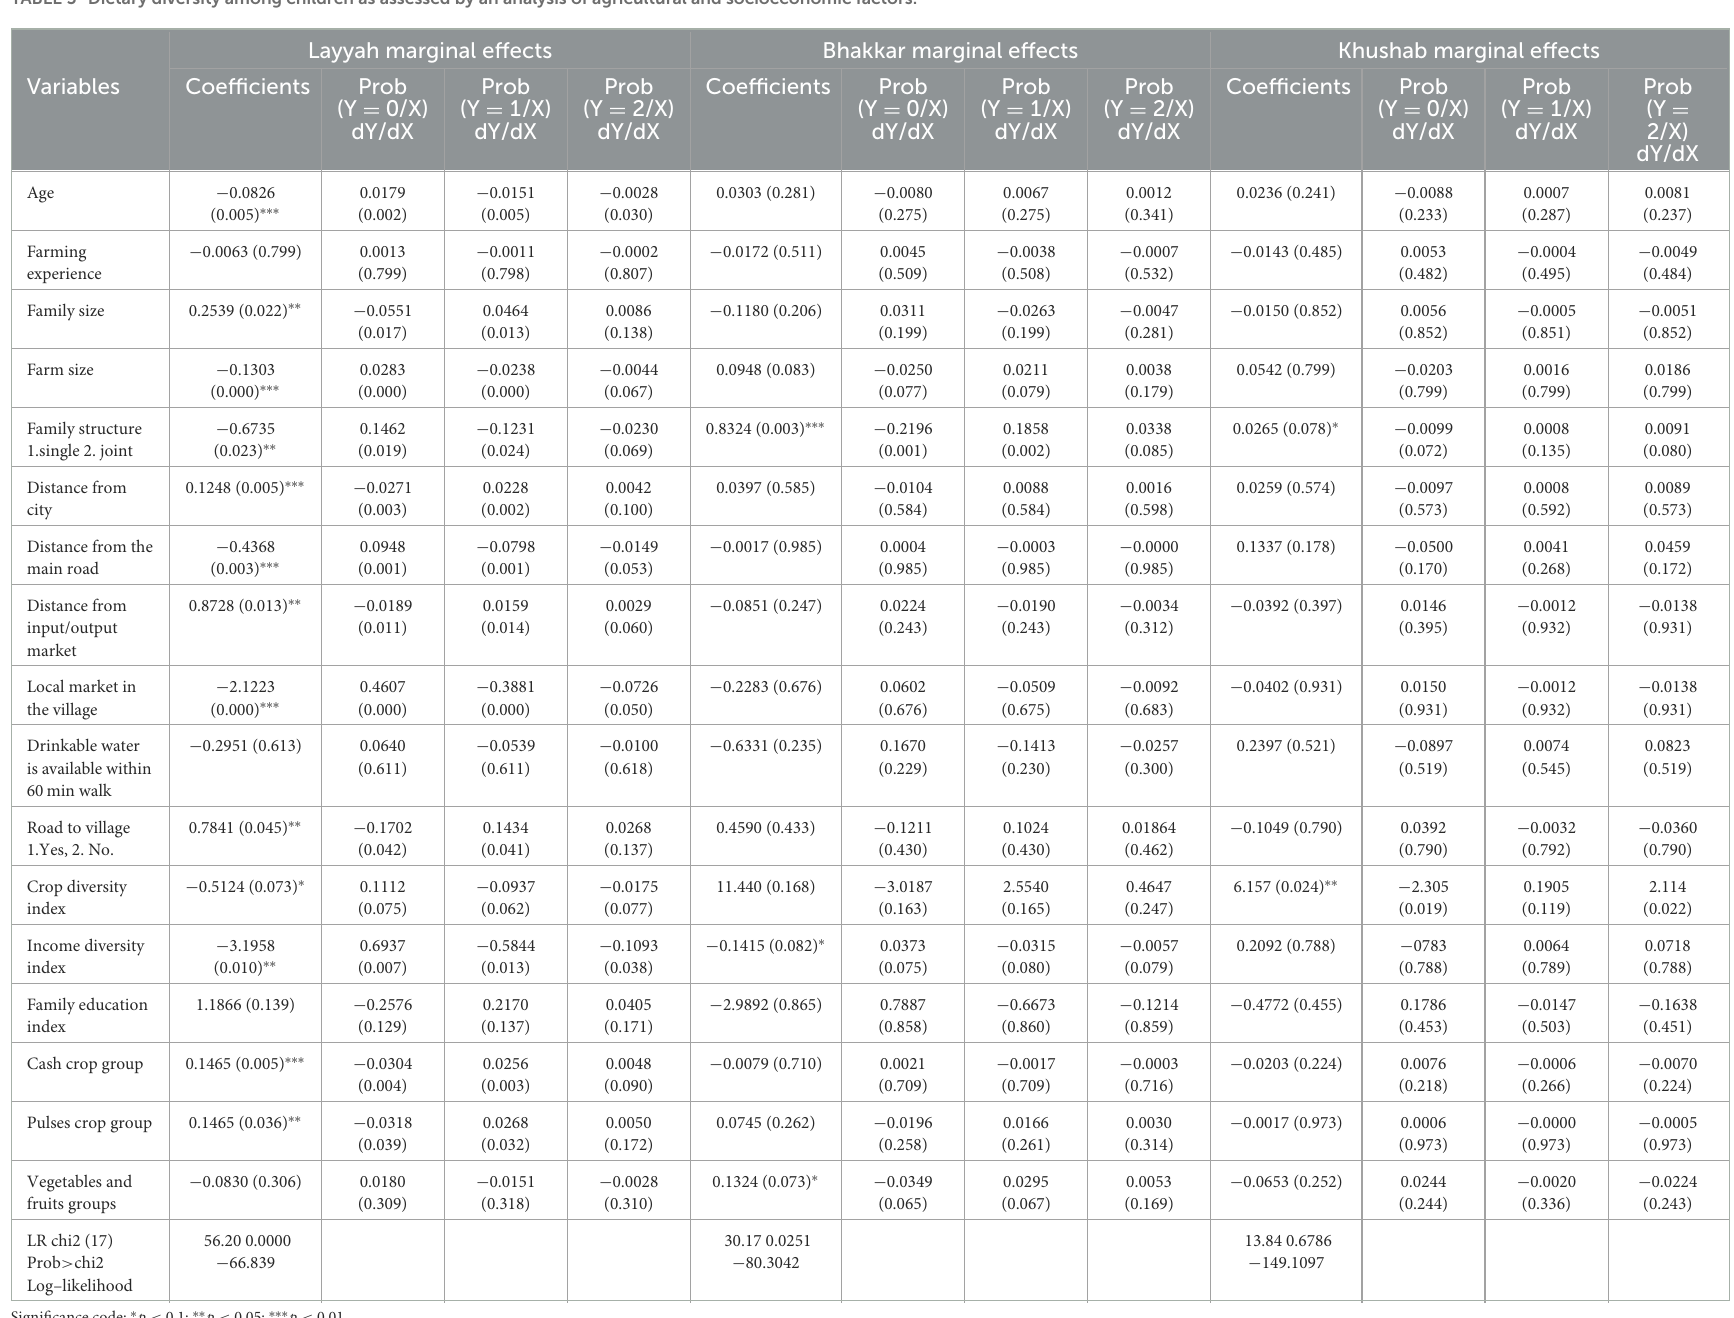
TABLE 5 Dietary diversity among children as assessed by an analysis of agricultural and socioeconomic